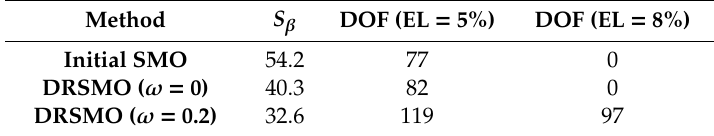
Table 3. The target 2 optimized values of S β , DOF (nm) corresponding to ELs equal to 5% and 8% for the conventional SMO, and DRSMO with ω = 0, ω = 0.1, ω = 0.2, and ω = 0.3, respectively.